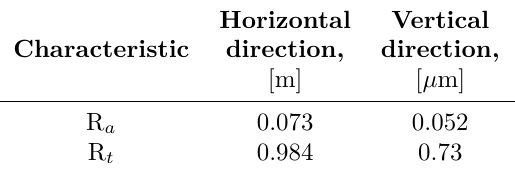
Table 1. ZrN coating microgeometrical characteristics.